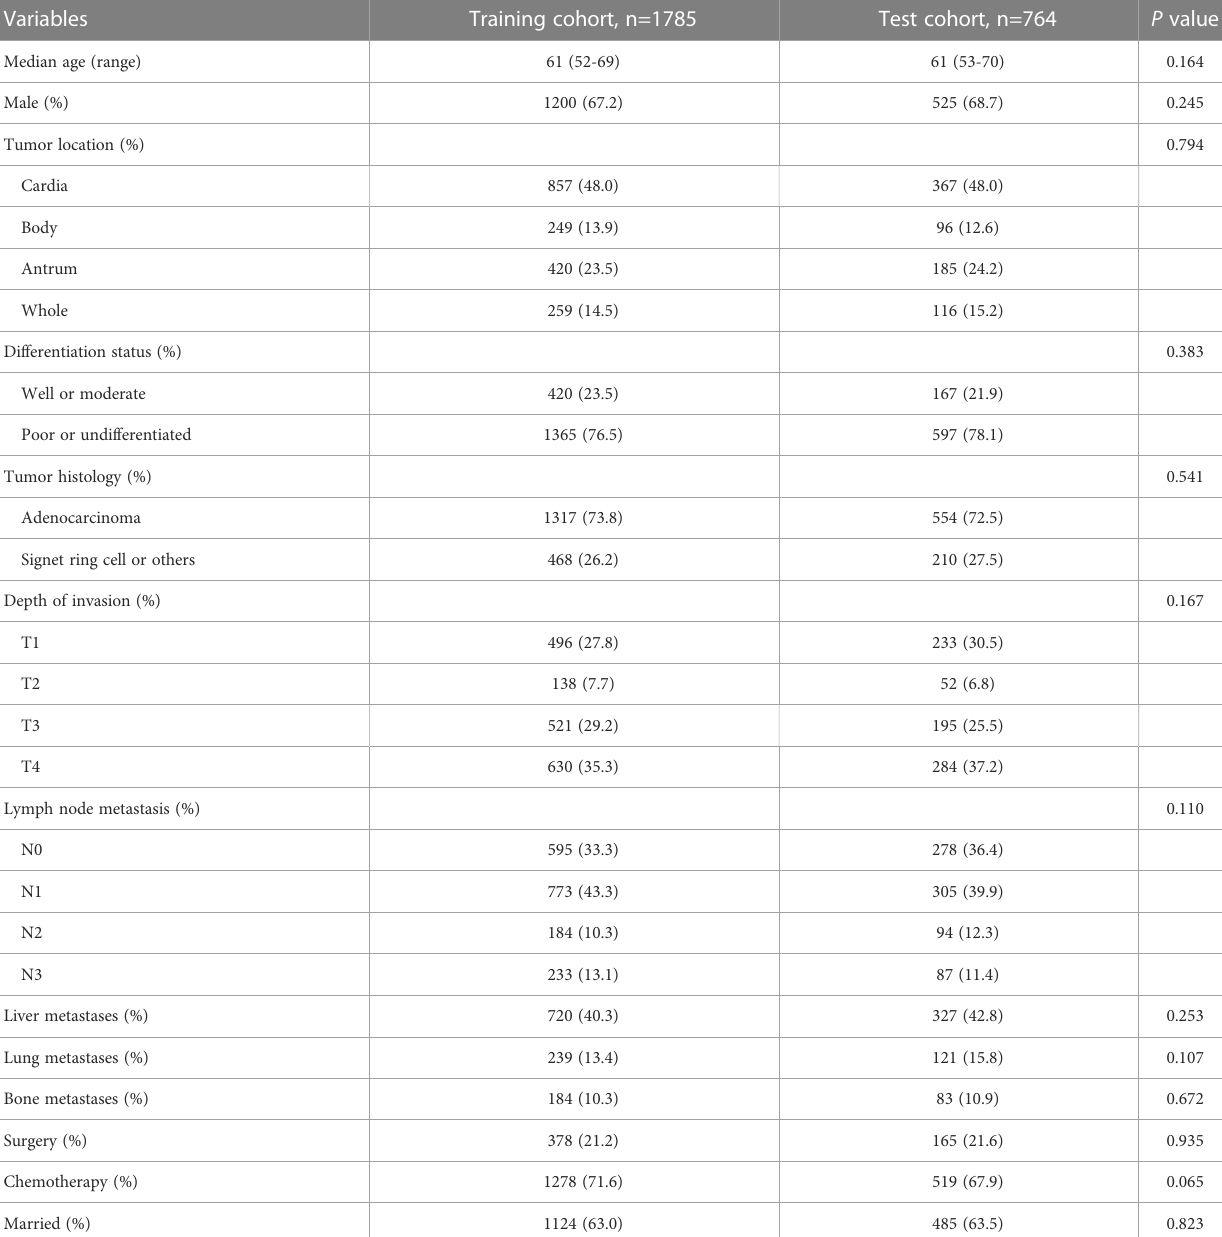
TABLE 1 Clinicopathologic characteristics of gastric cancer patients with distant metastases at fi rst diagnosis.